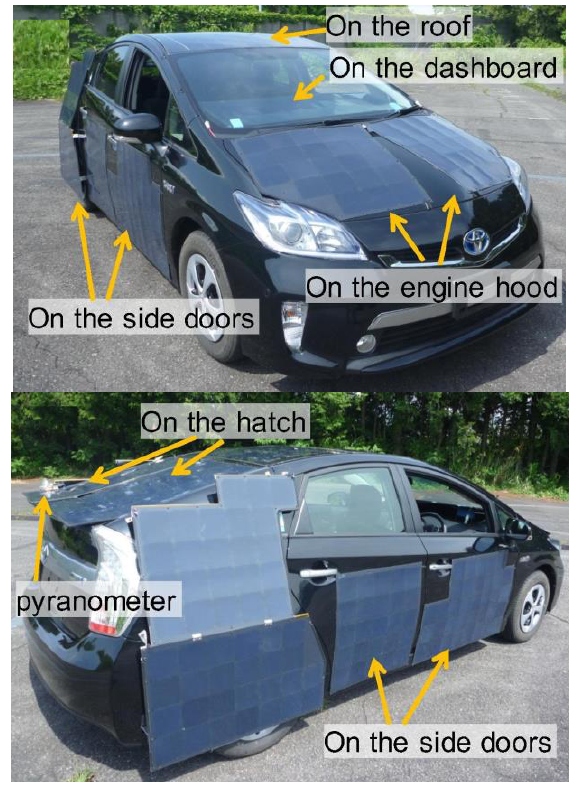
Fig . 9 Test vehicle Toyota Prius